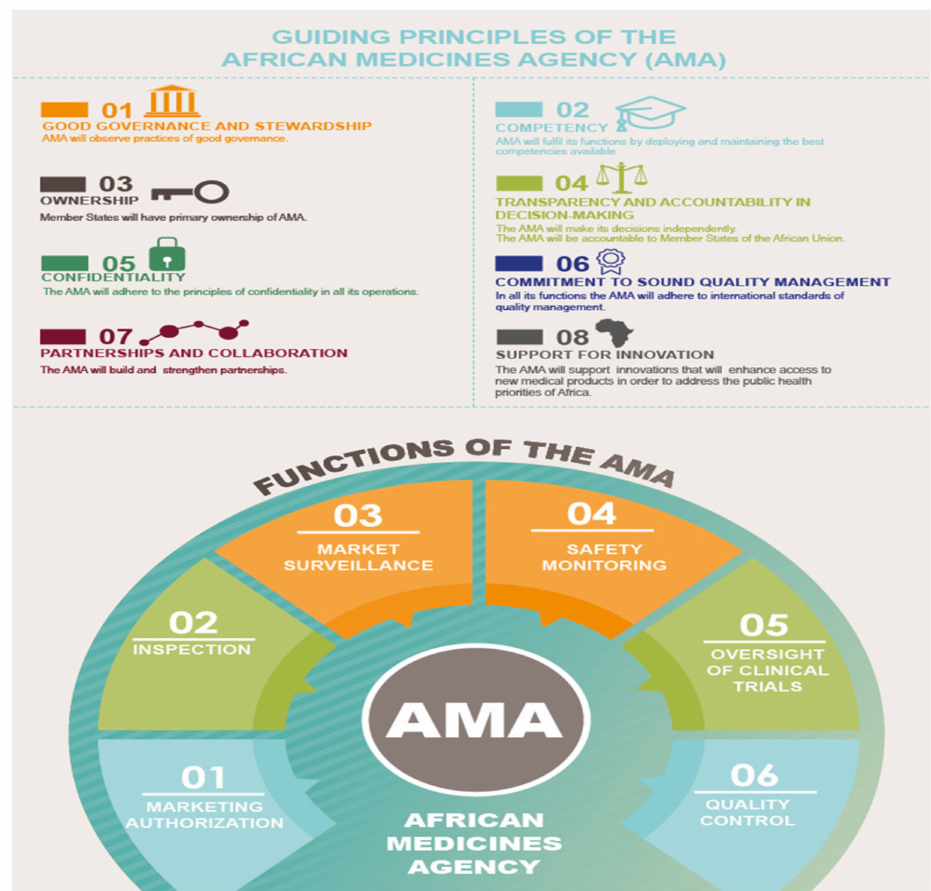
Figure 5. Guiding principles of African Medicines Agency. Source: AUDA-NEPAD https://nepad. org/microsite/african-medicines-agency-ama (accessed on 22 May